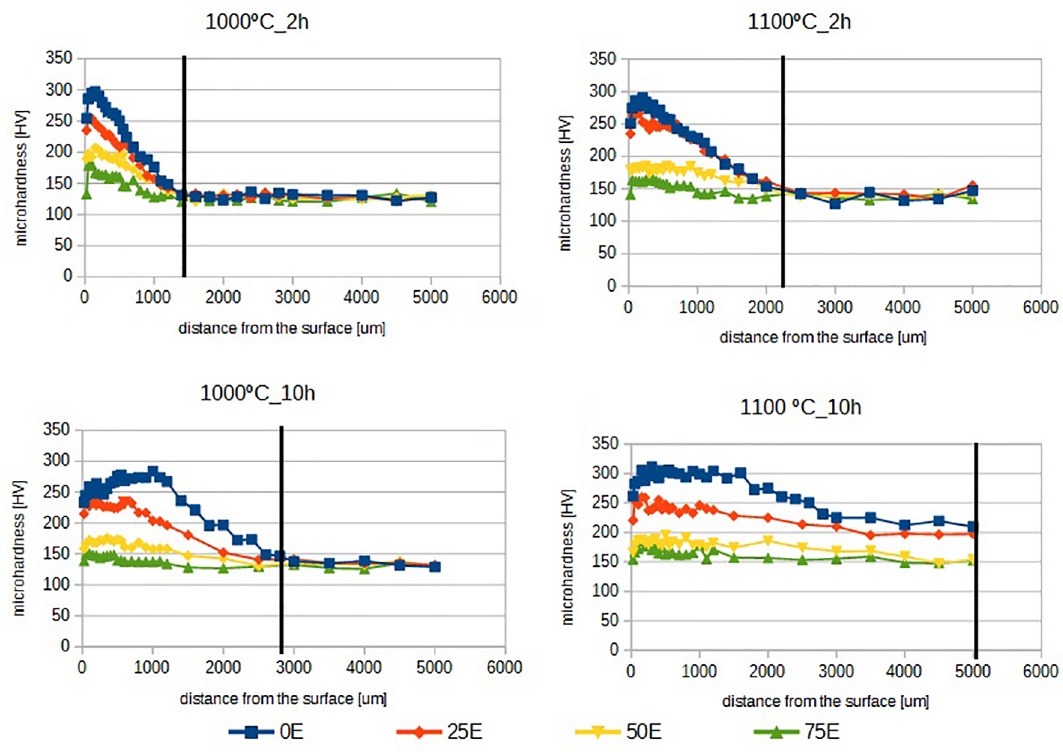
Figure 4. Hardness profiles of AISI 1020 steel thermochemically treated with Turbonit ® and mixtures Tubonit ® +Ekabor ® at 1000º C/1100º C for 2 h and 10